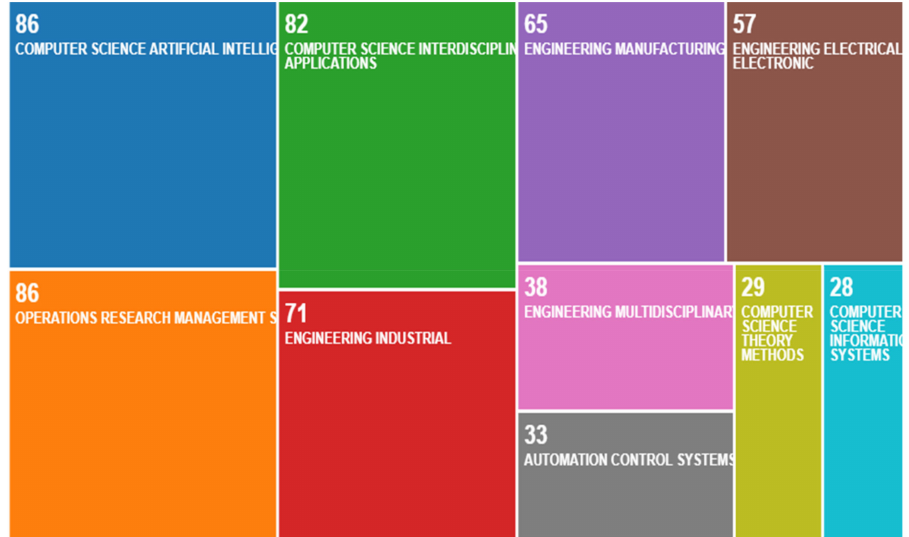
Figure 10. Treemap visualization of different categories (database: WoS https://clarivate.com/ products/web-of-science/, accessed on 31 December